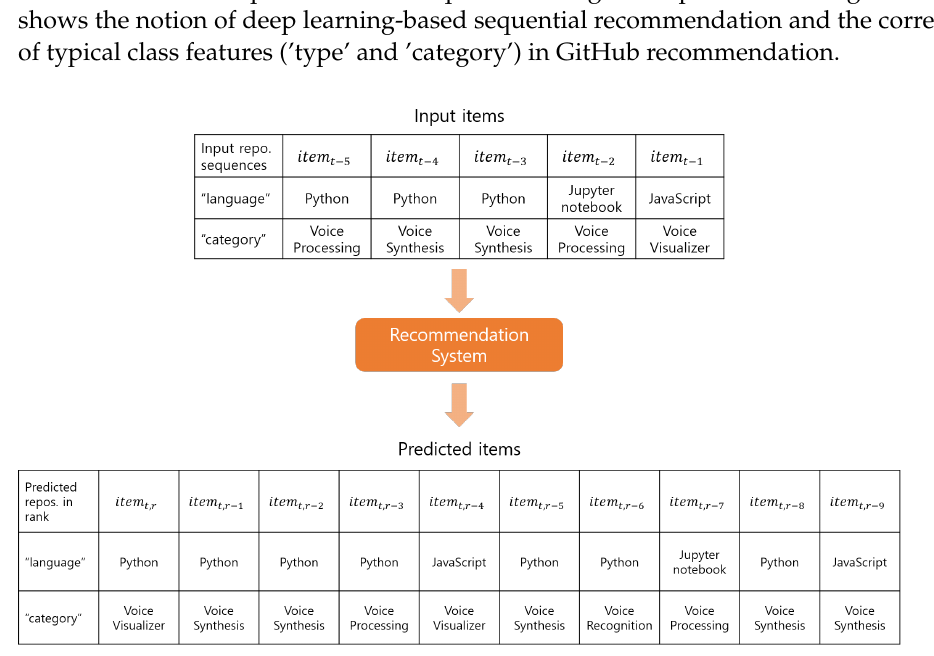
Figure 7. Example of predicted